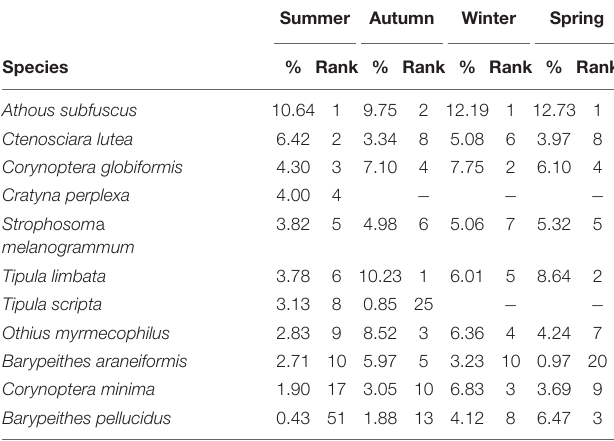
TABLE 1 | SIMPER analysis showing the contribution (%) of Insect OTUs assigned on species level with a blastID of at least 99% to the differences between extraction methods depending on